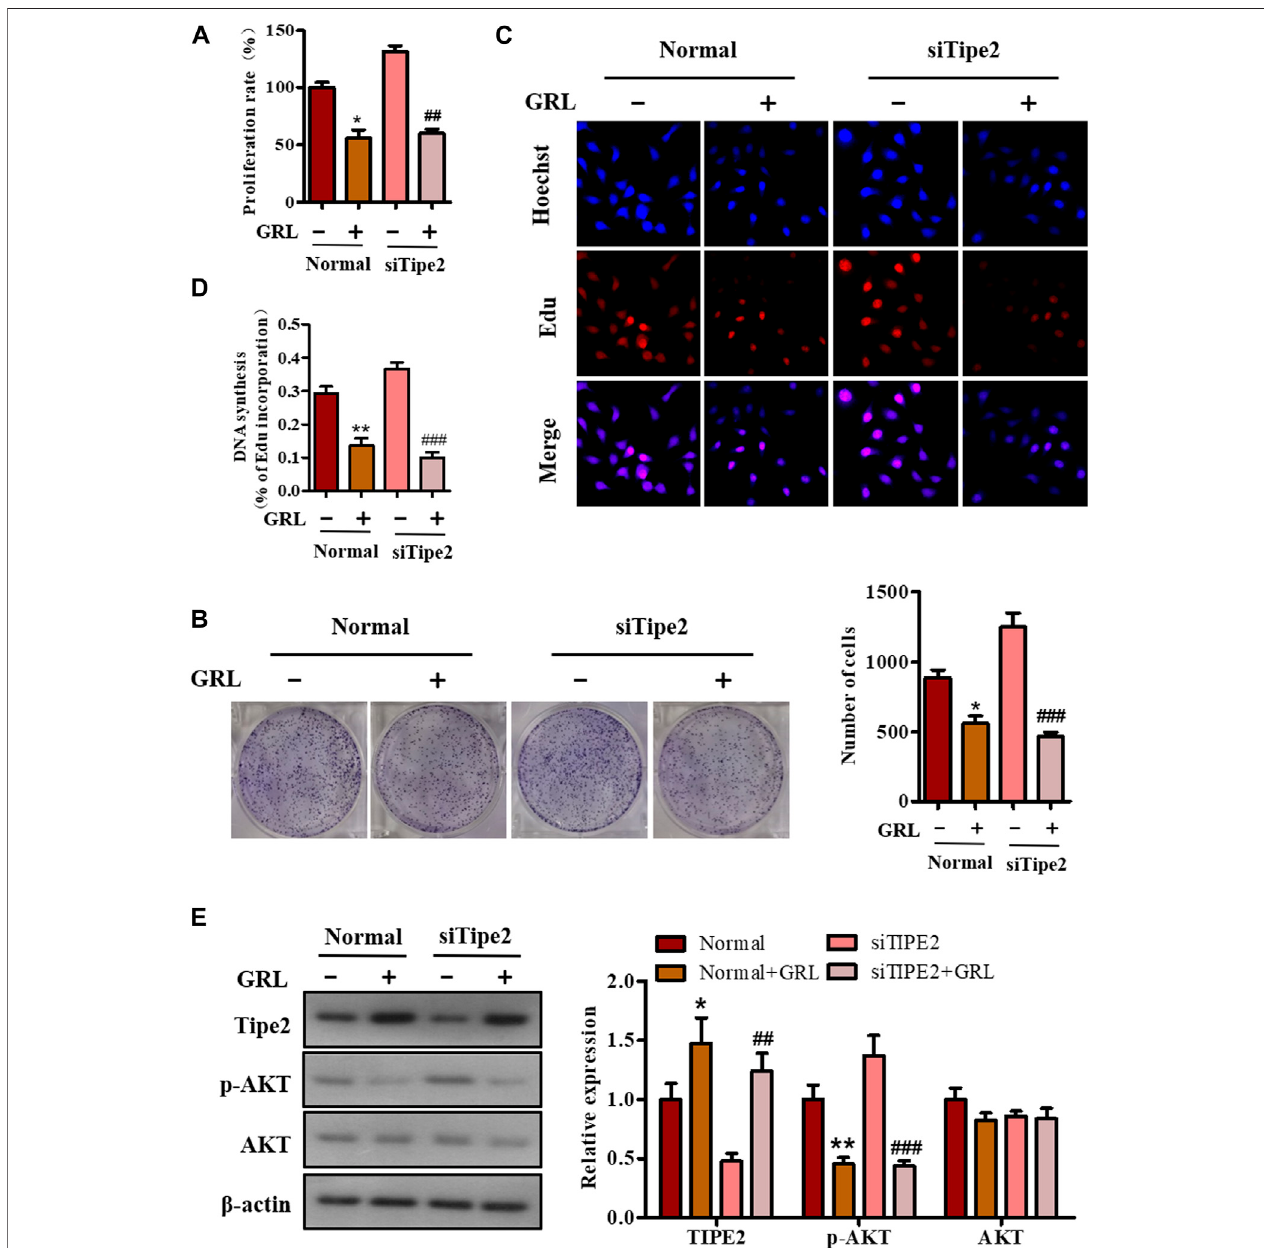
FIGURE4 | The role ofTIPE2 incell proliferation mediated by gracillin in BGC823 cells. (A) MTT assay forcell proliferation byTIPE2 and gracillin. 5 μ Mgracillin was used totreatthe BGC823 cells and TIPE2 siRNA BGC823 cells for 48 h. (B) Colony formationfor cell proliferation byTIPE2 and gracillin. 5 μ M gracillin wasused totreat the BGC823 cells and TIPE2 siRNA BGC823 cells for 7 days. (C) EdU staining for cell proliferation by TIPE2 and gracillin. 5 μ M gracillin was used to treat the BGC823 cells and TIPE2 siRNA BGC823 cells for 12 h. (D) The quantitative analysis for EdU staining. (E) Western blot for the expression of TIPE2, AKT, and p-AKT. The valuesofthehistogramaredisplayedasmean ± SD.0.01 < p < 0.05(*)representsasigni fi cantdifferenceand0.001 < p < 0.01(**)representsaverysigni fi cantdifference to the normal control; 0.001 < p < 0.01 ( ## ) represents a very signi fi cant difference and p < 0.001 ( ### ) represents an extremely signi fi cant difference to the TIPE2 siRNA control.